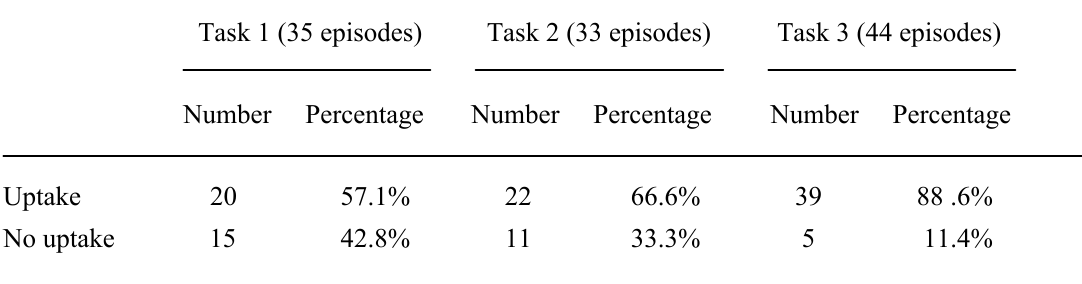
Uptake and no uptake of recasts, by task